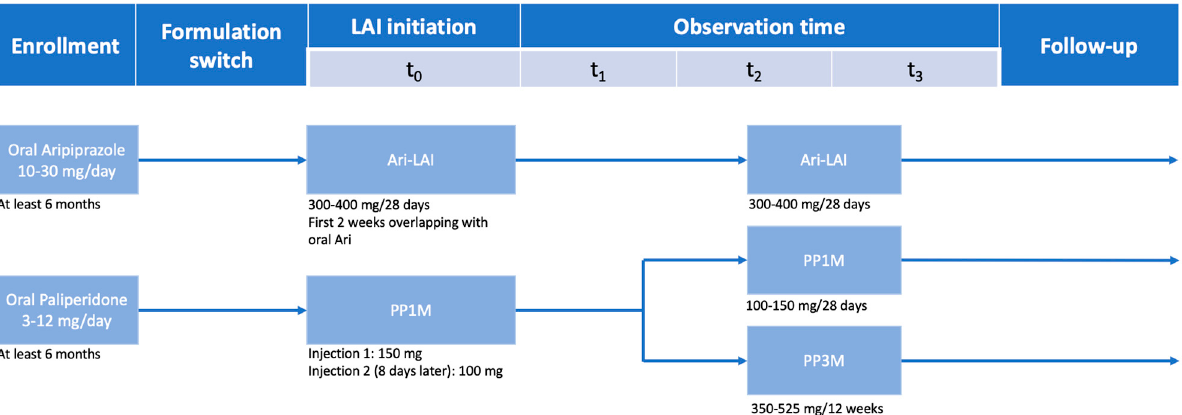
Figure 1. Study design infographics. Ari-LAI: LAI aripiprazole; PP1M: paliperidone palmitate 1 month; PP3M: paliperidone palmitate 3 months; t 0 : baseline; t 1 : 3 months; t 2 : 12 months; t 3 : 15 months.